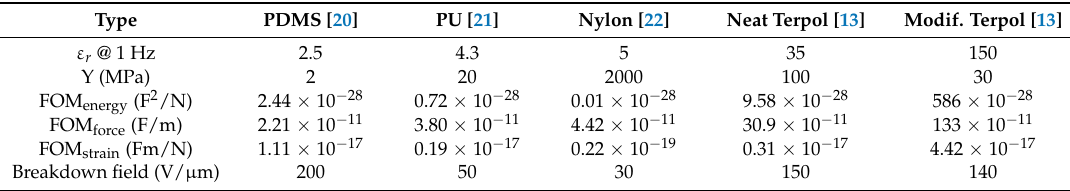
Table 1. Characteristics of different electroactive polymers.